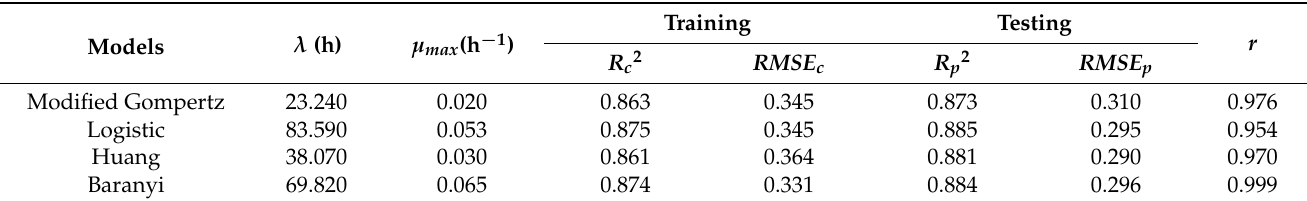
Table 7. Different kinetic-fitting models and parameters of sweetness by E-tongue in freshly squeezed strawberry juice during cold storage.